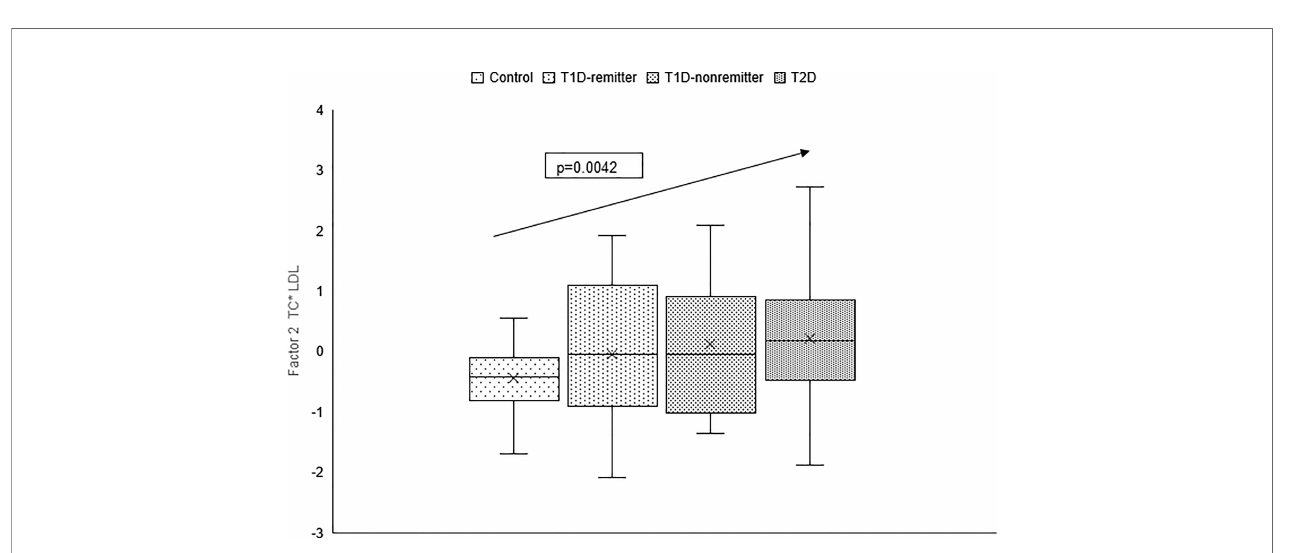
FIGURE 10 | Box plots of the factor analysis of the American Diabetes Association-recommended initial lipid parameters for the assessment of CVD risk in adults with diabetes namely, TG and HDL, and the atherogenic index of plasma, TG/HDL as designated as summary factor 2 (HDL*TG) obtained with the factor loading threshold of ≥ 0.45 in 203 adults. Factor 2 explained 90% of the variance in the original lipid parameters with a linear increase in mean composite scores from controls, remitters, non-remitters, and subjects with type 2 diabetes (p=0.0001)